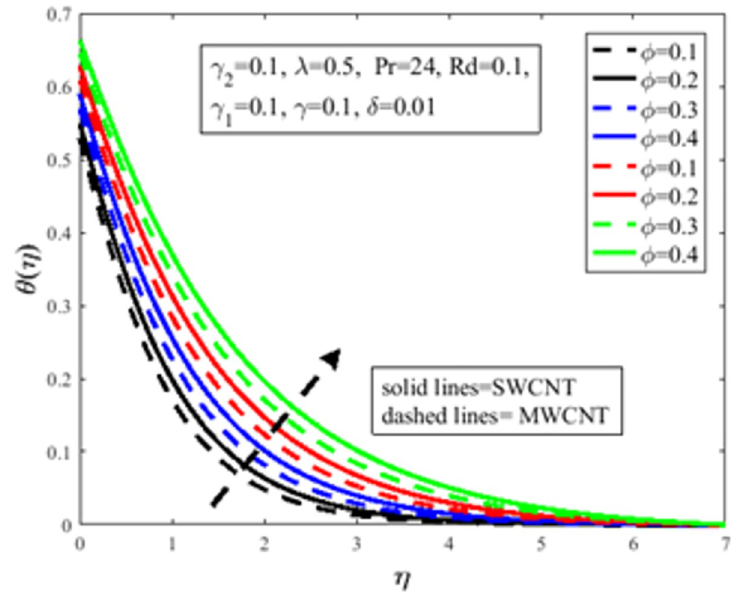
nanofluid declines which lessens the fluid temperature and θ ( η ). Fig 13 exhibits the parameter dependencies of thermal relaxation δ on the temperature field θ ( η ). Physically thermal relaxa- tion time is the time in which fluid is allowed to relax to retain its original shape. During this time the fluid behaviour is shear thickening. As a result of a rise in δ , the nanofluid particles show nonconducting behaviour, which takes a long time to convey heat to their neighboring nearby particles. The temperature distribution diminishes as a consequence. Fig 14 illustrates